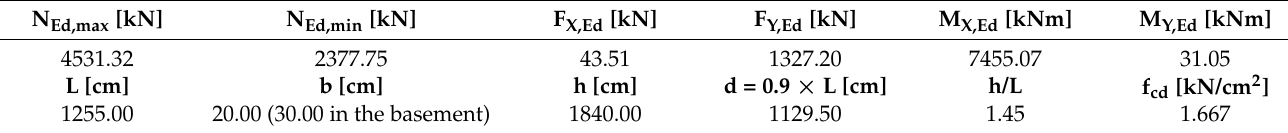
Table 8. Load effects and material characteristics for the shear wall in axis